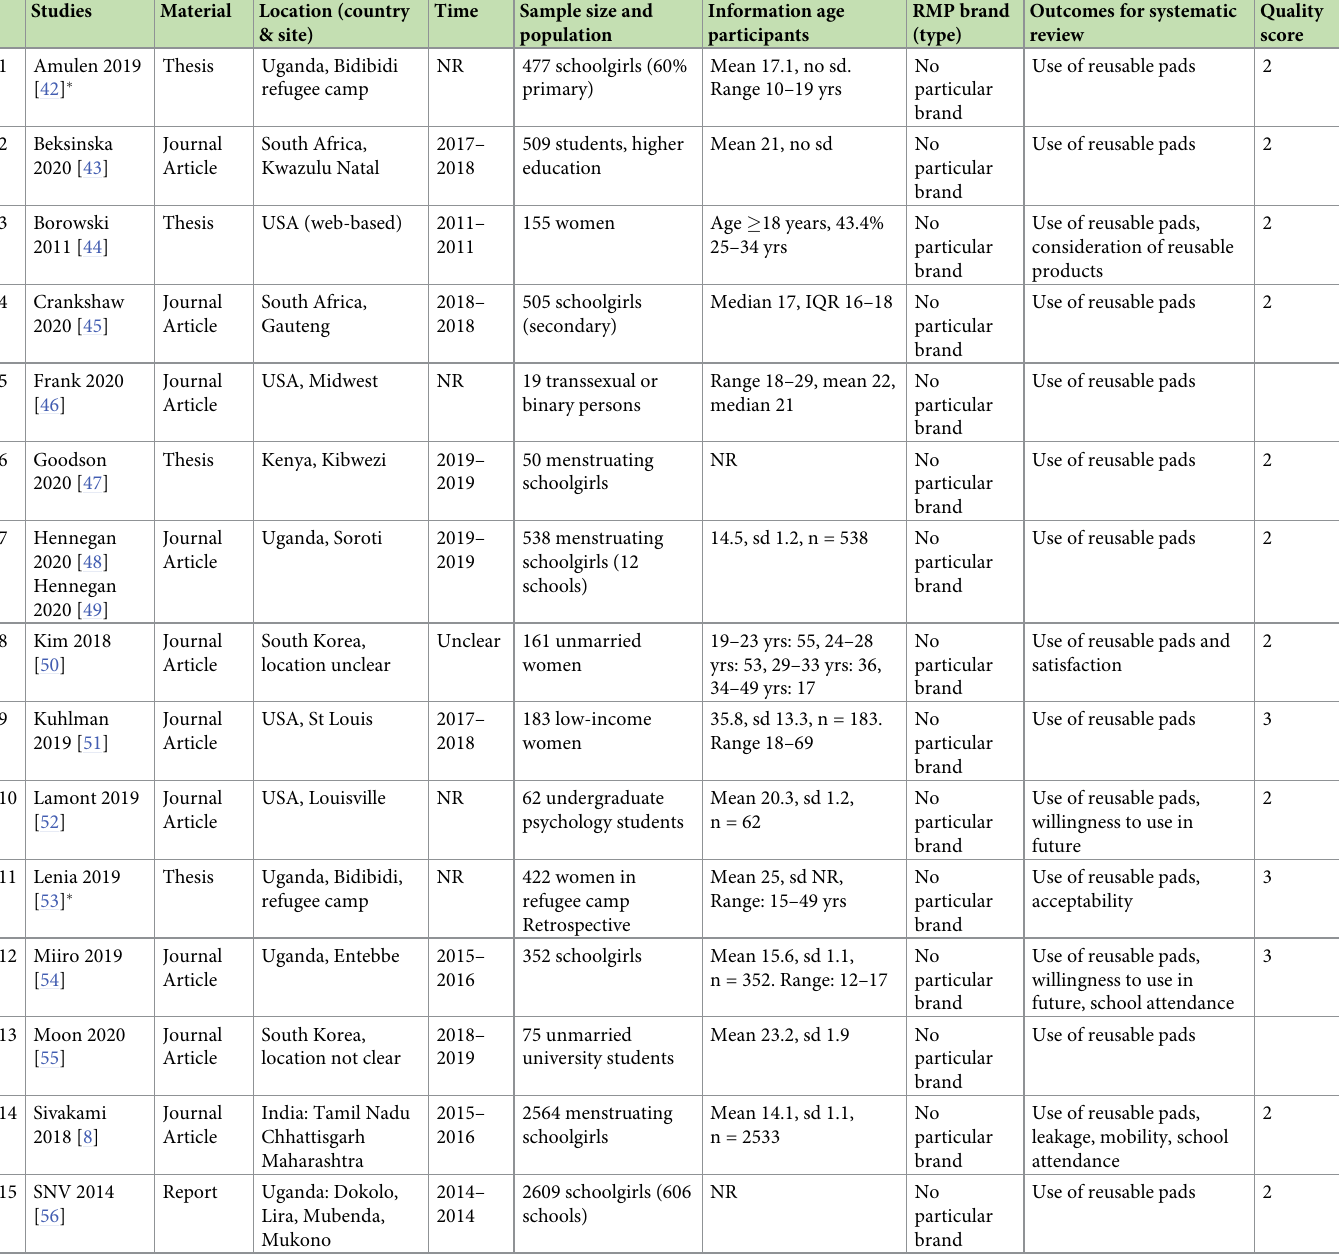
Table 1C. Characteristics of surveys contributing to the Reusable Menstrual Pad review (alphabetical order).